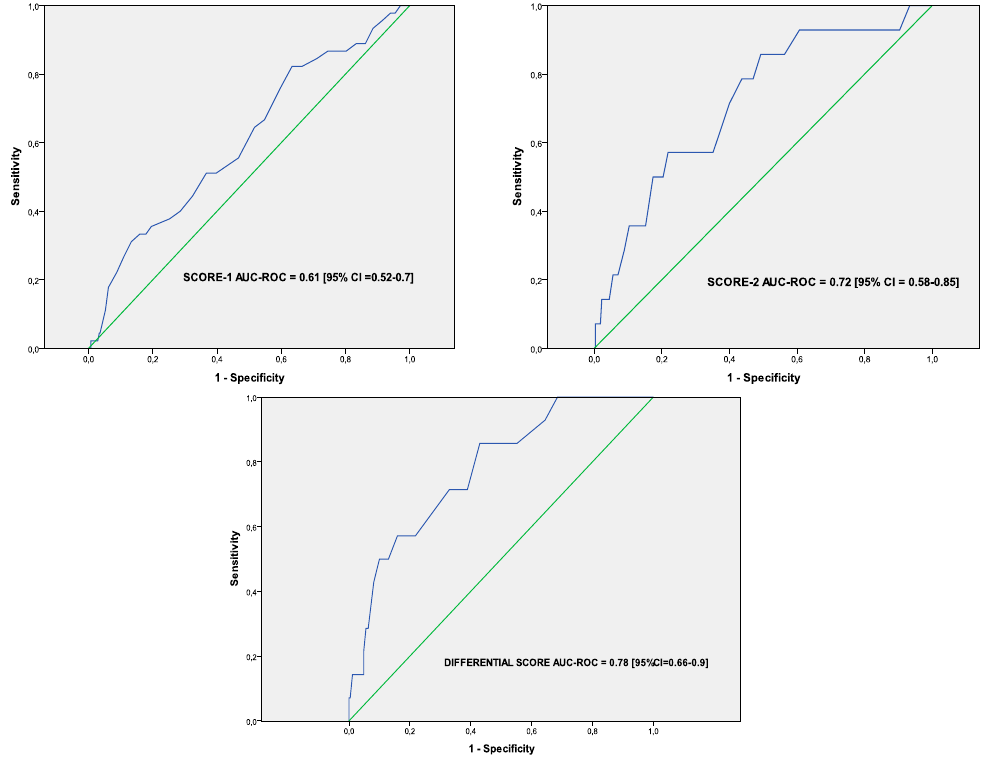
Figure 4. Discrimination power by means of the receiver operator characteristic and its area under the curve (AUC-ROC) of SCORE-1, SCORE-2 and DIFFERENTIAL SCORE.